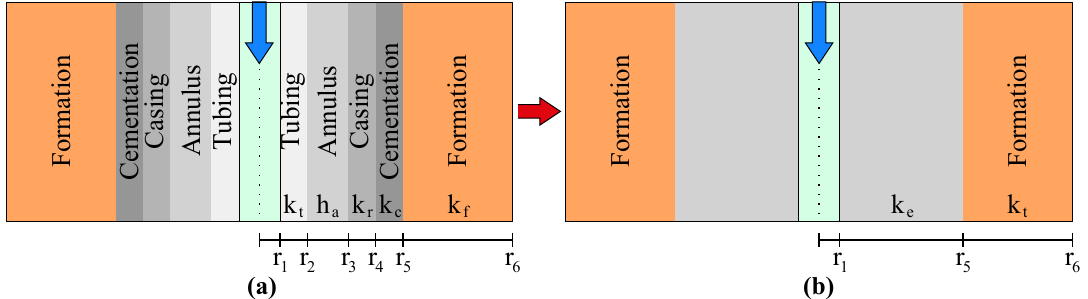
Figure 2. Equivalency between a well commonly used in the oil industry and a simplified structure of a well based on the wall layers conductivity analysis. ( a ) Profile of a typical structure found in the oil industry composed by: cementation, casing, annulus and tubing. The parameters k t , h a , k r and k c are the respective heat-transfer mechanism coefficients and r 1 , r 2 , r 3 , r 4 and r 5 the respective radiuses; ( b ) Simplified structure where all the coefficients are represented by a equivalent parameter k e .